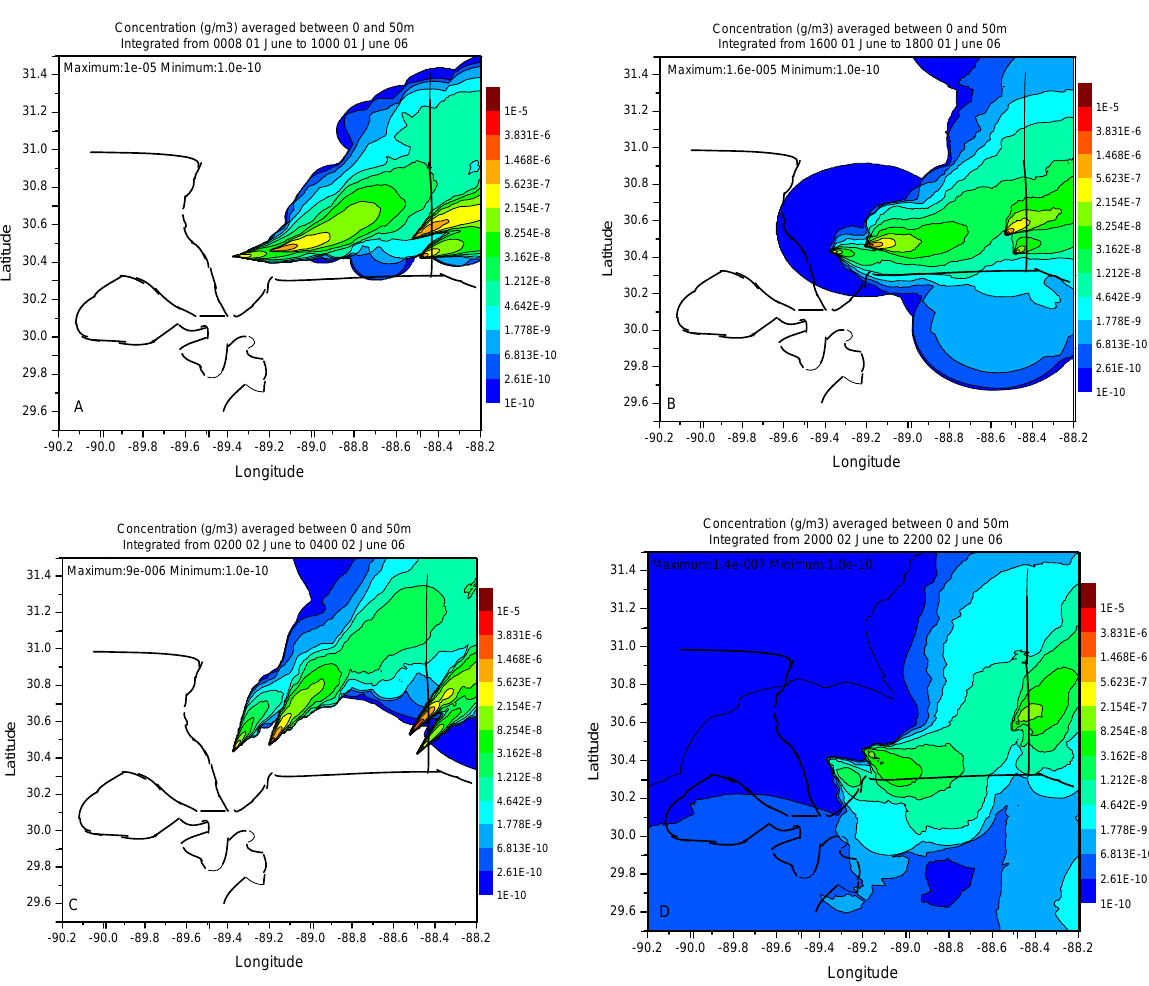
-90.2 -90.0 -89.8 -89.6 -89.4 -89.2 -89.0 -88.8 -88.6